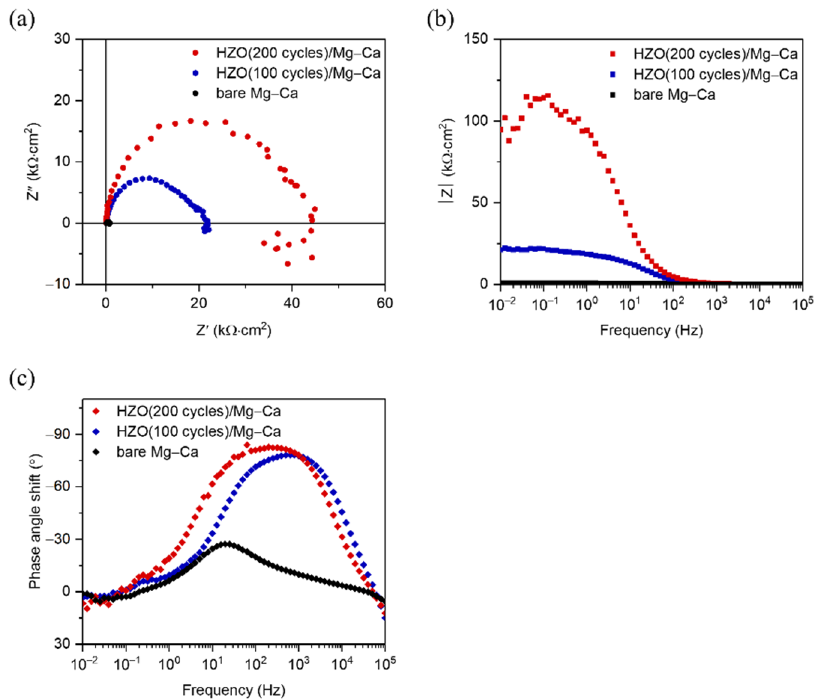
Figure 5. ( a ) Nyquist plots of bare Mg–Ca alloy and Mg–Ca alloy with HZO films of 100 and 200 cycles. ( b ) Bode plots of absolute impedance, and ( c ) phase angle shift of output wave of HZO films of 100 and 200 cycles.